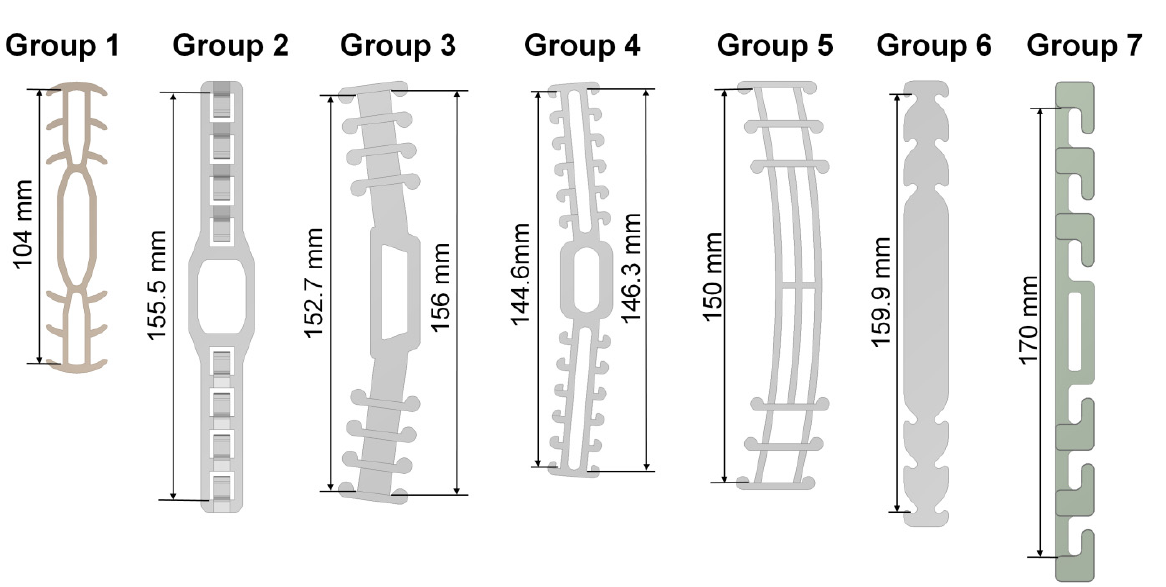
Figure 1. Seven different computer models of SMTRBs. Table 1. Groups of SMTRBs.